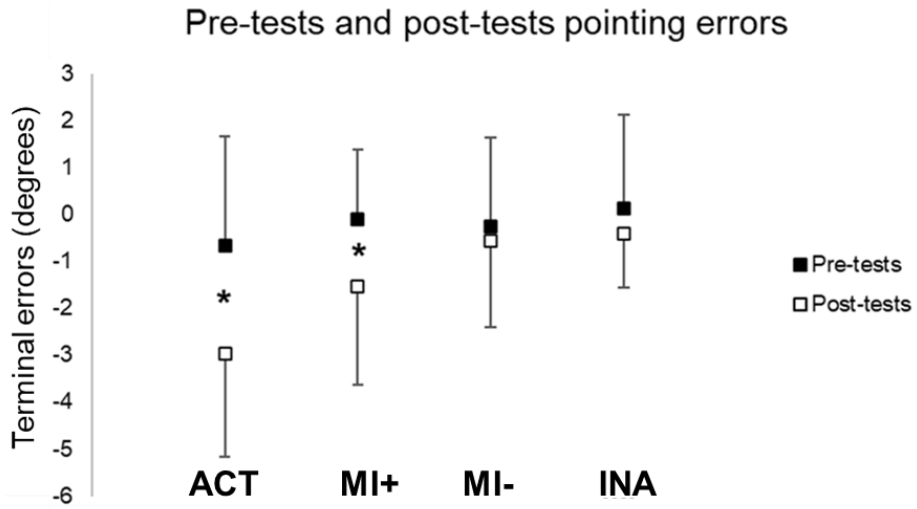
Figure 3. Pointing terminal errors during pre and post-tests. Values are reported with standard deviations. * means significance at p < 0.01. ACT: active group; MI: motor Imagery groups with higher (+) versus lower ( − ) MI abilities; INA: inactive group.